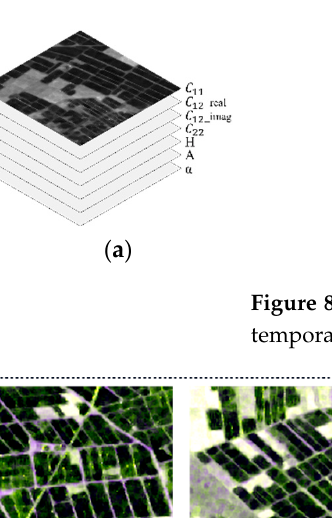
Remote Sens. 2022 , 14 , x FOR PEER REVIEW